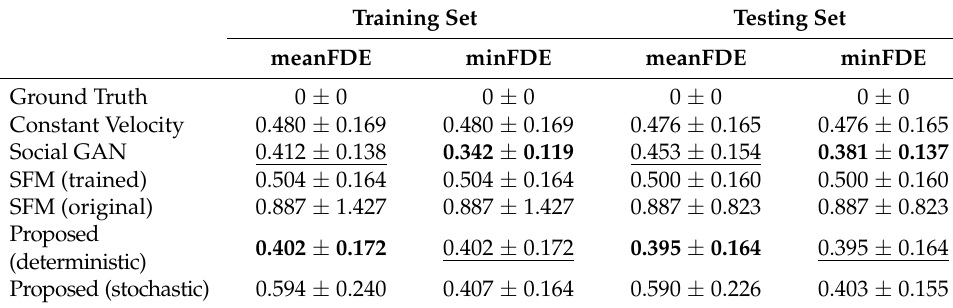
Table 5. Evaluation of FDE